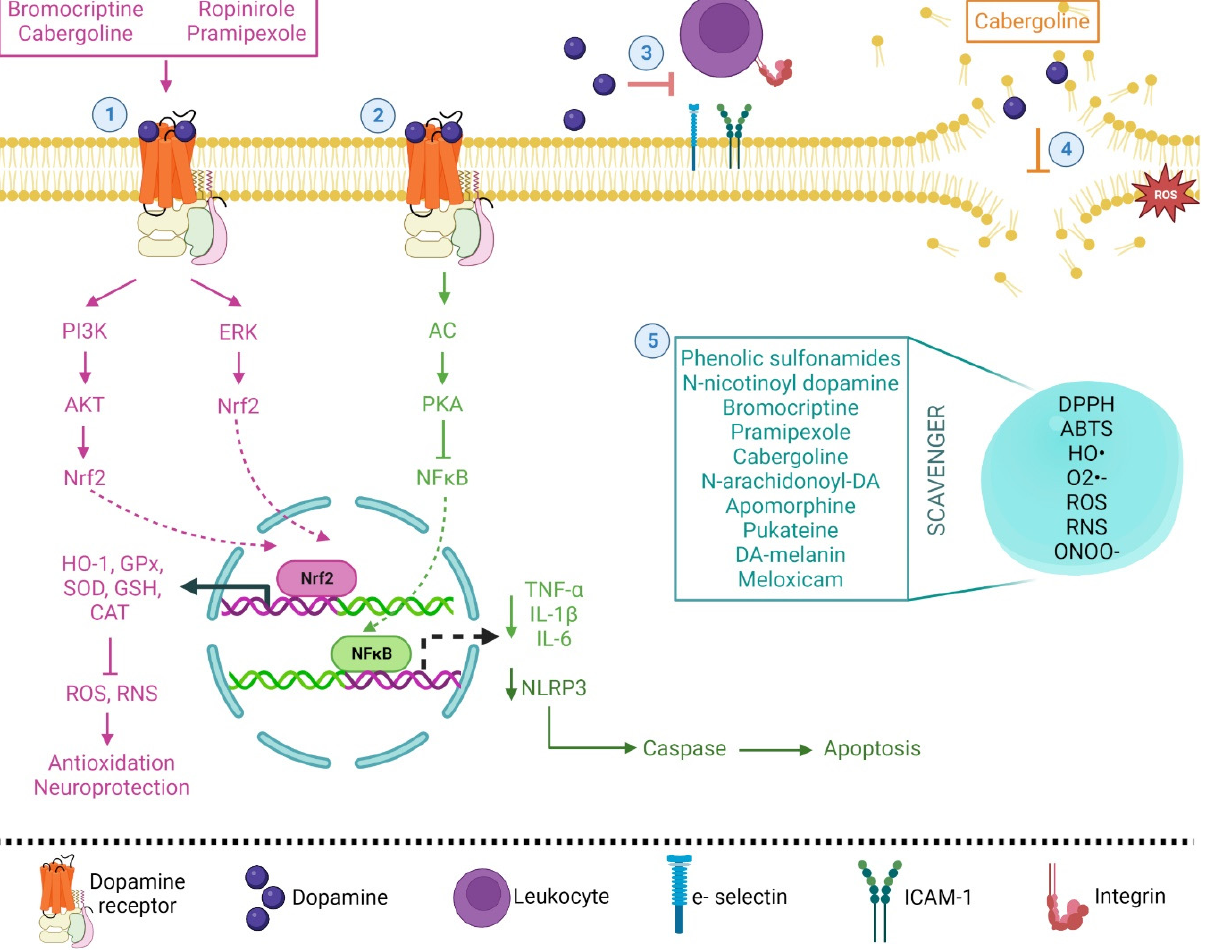
Figure 3. Simplified and integrated mechanisms of dopamine and its agonist, as antioxidant and anti-inflammatory molecules, in various physiological processes. (1) The binding of dopamine and some agonist drugs with its receptor activates the PI3K/AKT or ERK signaling pathway, resulting in Nrf2 translocation to the nucleus, inducing the expression of HO-1 and antioxidant genes (pink pathway). (2) The activation of AC/PKA inhibits NF- κ B, generating a decrease in proinflammatory cytokine expression and the protein complex NLRP3 inflammasome, thus diminishing the apoptotic process (green pathway). (3) Dopamine attenuates the chemoattractant effect of integrins and adhesion molecules. (4) Cabergoline and dopamine inhibited the peroxidation of brain phospholipids and reacted with free radicals. (5) Some drugs showed scavenger capacity and protection against ROS accumulation (cyan box).